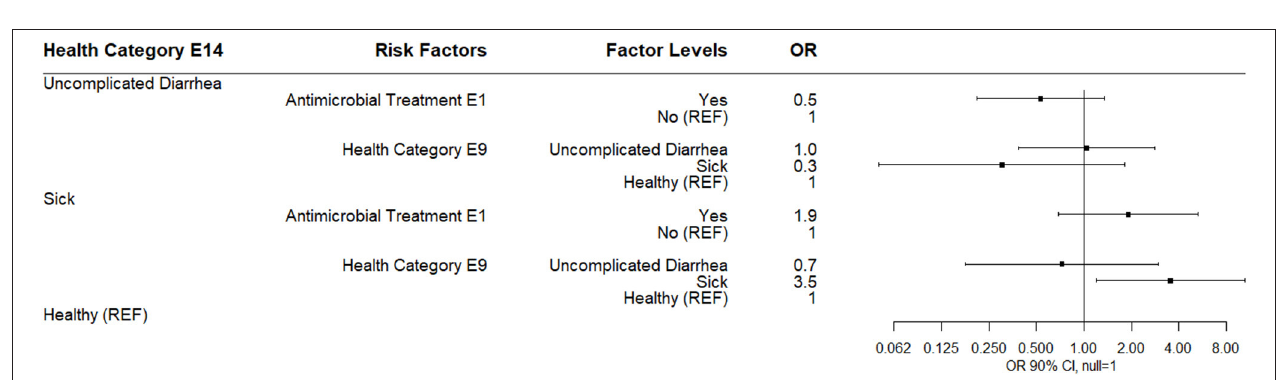
FIGURE 9 | Results of multinomial logistic regression modeling health category at sampling day E14. Odds ratios and 90% confidence intervals are